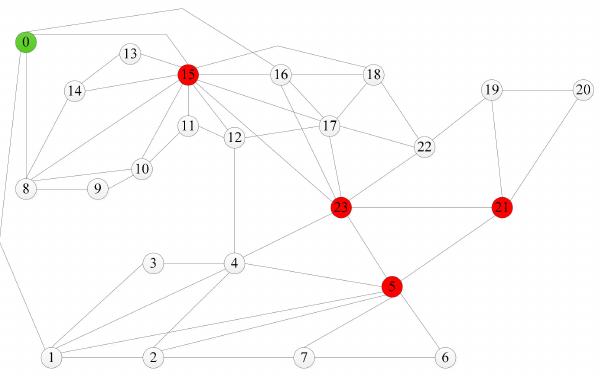
Figure 10. Connection structure of the dispatch